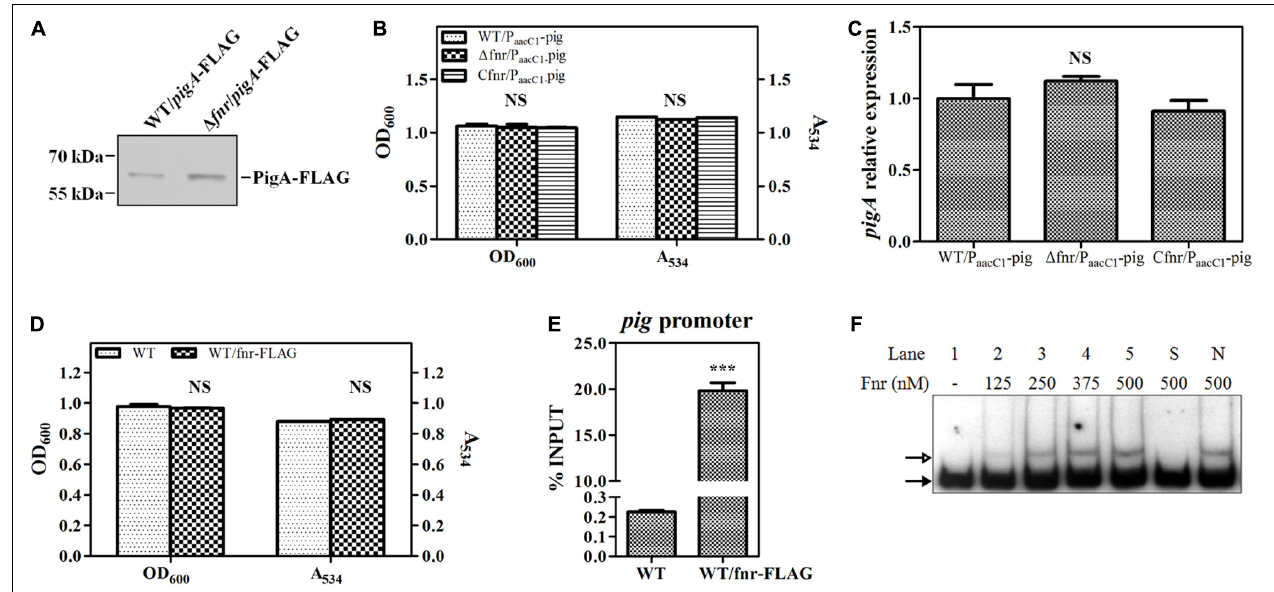
FIGURE 3 | Fnr directly binds to the promoter of the pig gene cluster. (A) Western blotting analysis of FLAG-labeled PigA in WT and (cid:49) fnr strains; 2 µ g of total protein was loaded onto the gel. (B) Cell growth and prodigiosin production of WT/P aacC 1 - pig , (cid:49) fnr /P aacC 1 - pig , and C fnr /P aacC 1 - pig . (C) Transcription level of pigA in WT/P aacC 1 - pig , (cid:49) fnr /P aacC 1 - pig , and C fnr /P aacC 1 - pig strains. The transcription level of the tested genes in WT/P aacC 1 - pig was assigned as 1. (D) Cell growth and prodigiosin production of WT and WT/fnr-FLAG. (E) In vivo ChIP-qPCR analysis of Fnr-FLAG binding to the promoter of the pig gene cluster. An anti-FLAG affinity gel was used to precipitate the protein-DNA complex, and WT was used as the negative control. The Y -axis indicates the relative enrichment value of Fnr on its target site, which was calculated by comparing the Ct value of the sample and input. (F) In vitro EMSA of His 6 -Fnr binding to the pig promoter probe. The concentration of Fnr supplied in each lane is shown, and each lane contained 0.2 nM-labeled DNA probe. Competitive analysis was performed in lane S (supplied with a 100-fold excess of unlabeled specific probe) and lane N (supplied with a 100-fold excess of unlabeled non-specific probe). The solid and hollow arrows indicate the free probe and shifted probe, respectively. Experiments were performed in triplicate, and data are shown in the form of mean ± SD. Student’s t -test was used to analyze the statistical significance (NS, no significance; *** p <